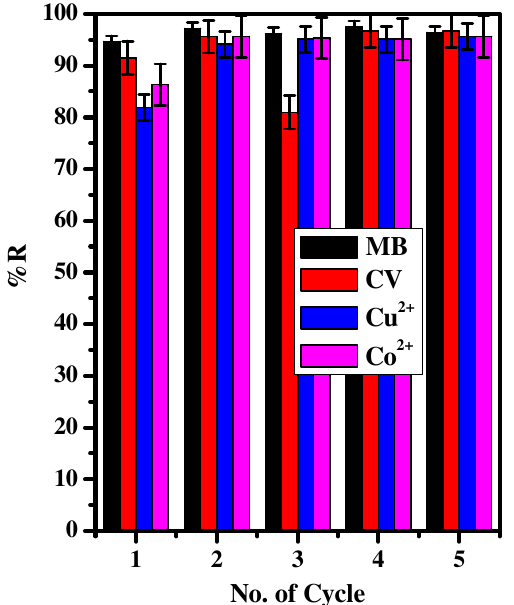
Figure 8. The effect of the number of the re-use cycles of the GO–C on the removal percentage of MB-dye (t = 5 min, [MB] = 30 ppm, dose = 6 mg, v = 50 ml, pH = 7), CV-dye (t = 5 min, [CV] = 30 ppm, dose = 4 mg, v = 50 ml, pH = 7), Cu 2+ ([Cu] = 100 mg l −1 , Dose = 6 mg, v = 5 ml, pH = 6, T = 25 °C) and Co 2+ ([Co] = 100 mg l −1 , Dose = 6 mg, v = 5 ml, pH = 8, T = 25 °C) form aqueous media. The regenerated solution (10 ml (10%HCl) + 5 mL (1 M